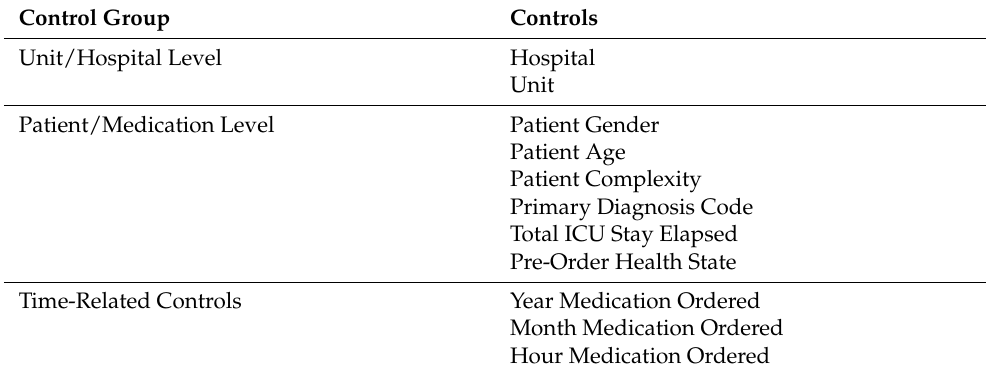
Table 2. Control variables included in regression